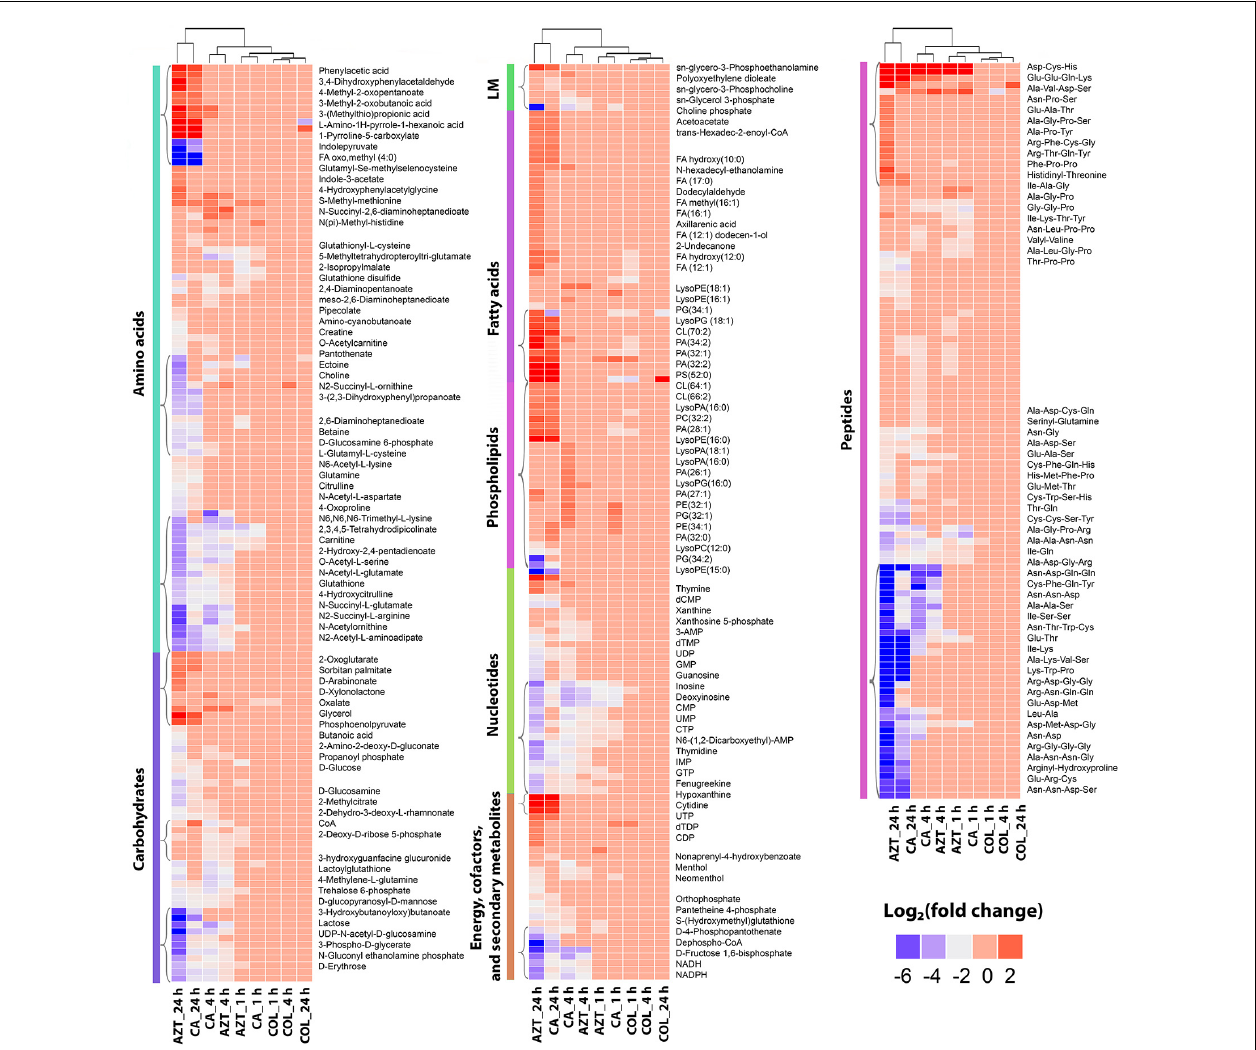
FIGURE 3 | Clustered heatmap profiles of the relative abundance for significantly affected metabolites in A. baumannii AB090342. Metabolites are grouped into different classes: amino acids, carbohydrates, lipids (lipid metabolism [LM], fatty acids and phospholipids), nucleotides, energy, secondary metabolites and peptides. The colors indicate the relative abundance of significantly affected metabolites by all three treatments (colistin alone, aztreonam alone and the combination) at 1, 4, and 24 h compared to the untreated control samples. Metabolite names were only labeled for top-significant metabolites as shown in single brackets. Blue and gray, significantly decrease (log 2 FC ≤ –1); red, significantly increase (log 2 FC ≥ 1); and pink, not